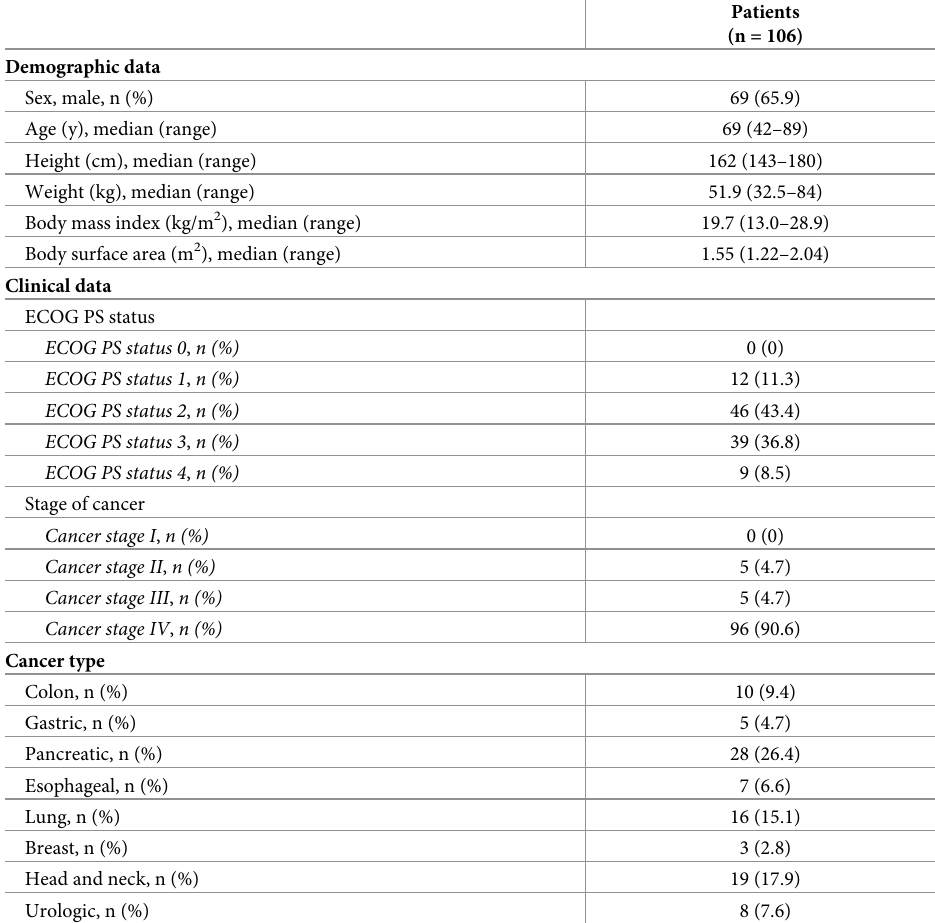
Table 1. Patient demographics and baseline clinical